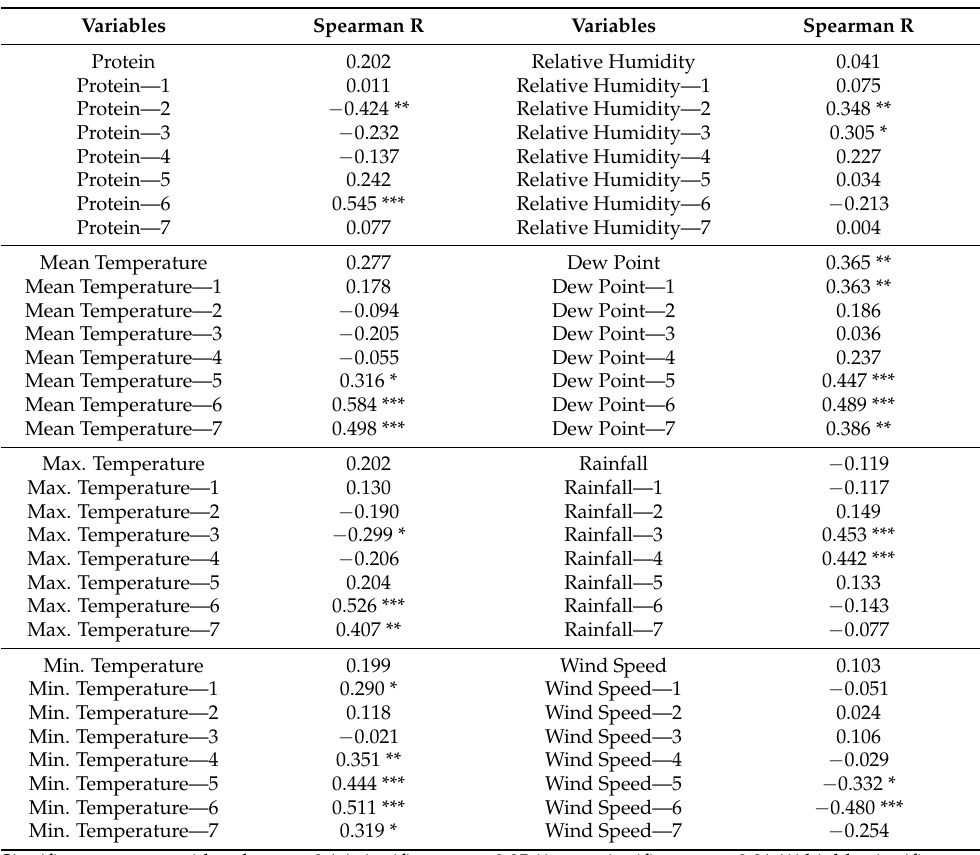
Table 3. Spearman’s correlation coefficients between airborne conidia concentrations and the consid- ered aerobiological and meteorological